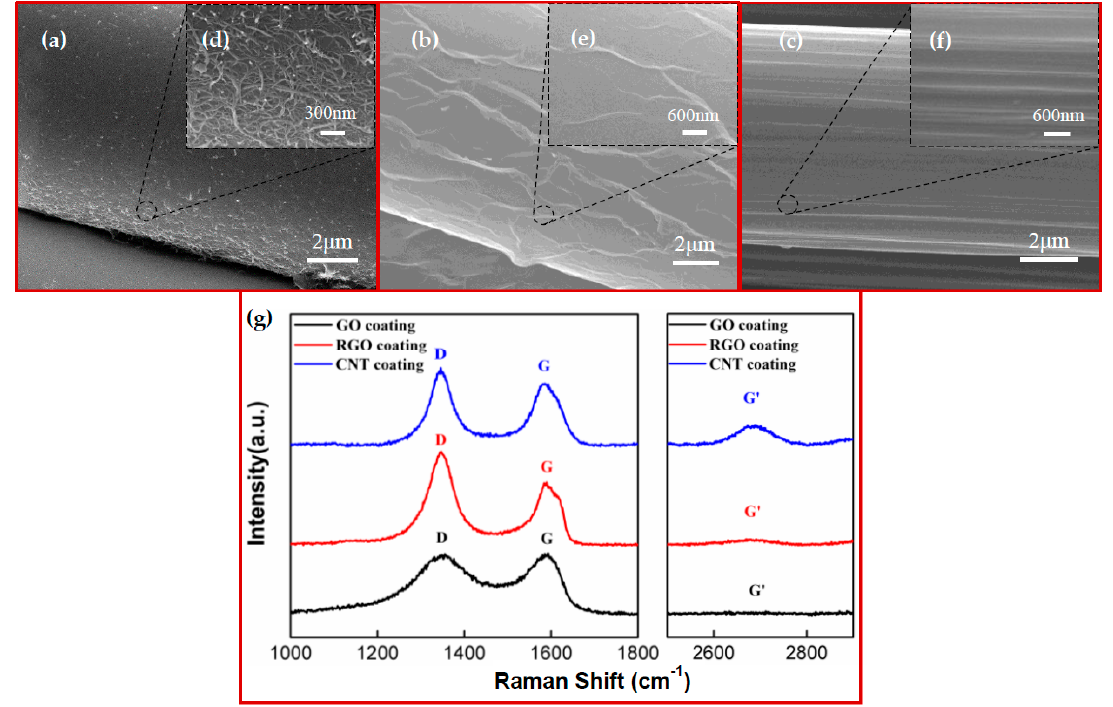
Figure 2. ( a – c ) SEM images of the CNT- and RGO-coated fibers, as well as CF, at a low magnification. ( d – f ) SEM images of CNT- and RGO-coated fibers, as well as CF, at a high magnification. ( g ) Raman spectrum of GO, RGO, and CNT coatings.